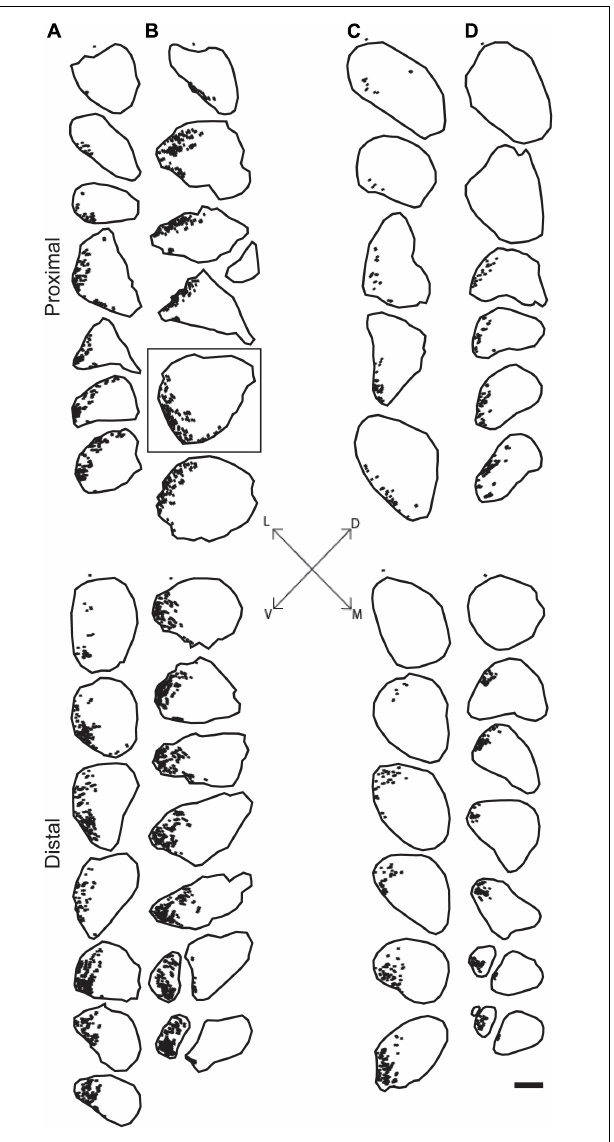
FIGURE 3 | Representative reconstructions from the left (A,C) and right (B,D) sciatic nerves in a male (A,B) and female (C,D) rat showing the location of motor axons projecting to the TA muscle. Reconstructions were made at 500 µ m intervals but are shown at 1,500 µ m intervals for illustrative purposes. BHRP-labeled axons (indicated by black dots) were confined to a discrete position throughout the nerve. Black outlines indicate the transverse area of the entire nerve measured from darkfield images. Fiduciary marks indicated by asterisks in each reconstruction. Inset: Dorsoventral and mediolateral directions. Box indicates reconstruction of the same section shown in Figure 1C . Scale bar = 500 µ